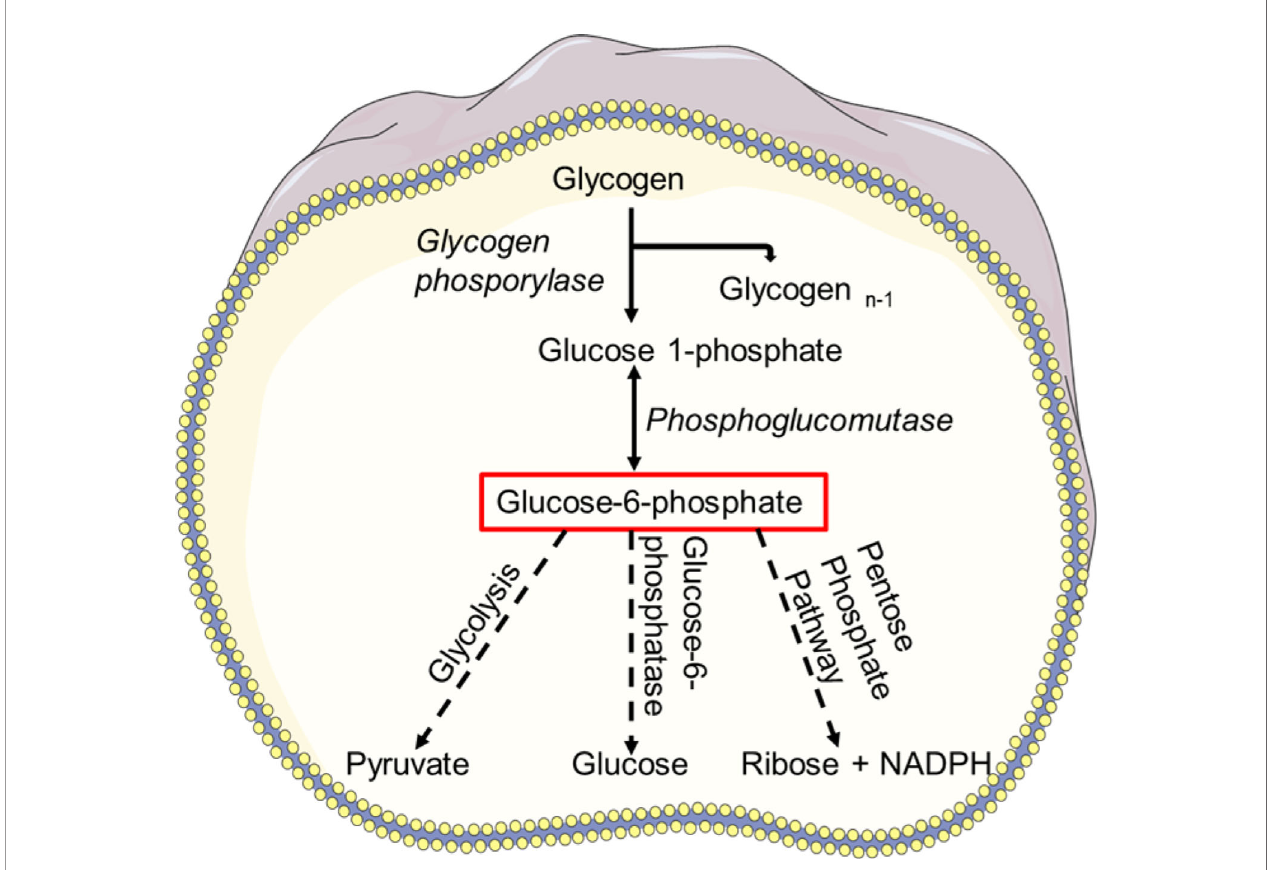
FIGURE 3 | Glycogen metabolism. Breakdown of glycogen results in glucose-1 phosphate which is then converted to glucose-6-phosphate (G6P) by phosphoglucomutase. G6P can enter the glycolysis pathway and used as a source of energy. Using glucose-6-phosphatase (G6Pase), G6P can be hydrolyzed to glucose via gluconeogenesis and subsequently released into the blood. Glucose-6-phosphate can also be taken by PPP and converted to NADPH or ribose in a variety of